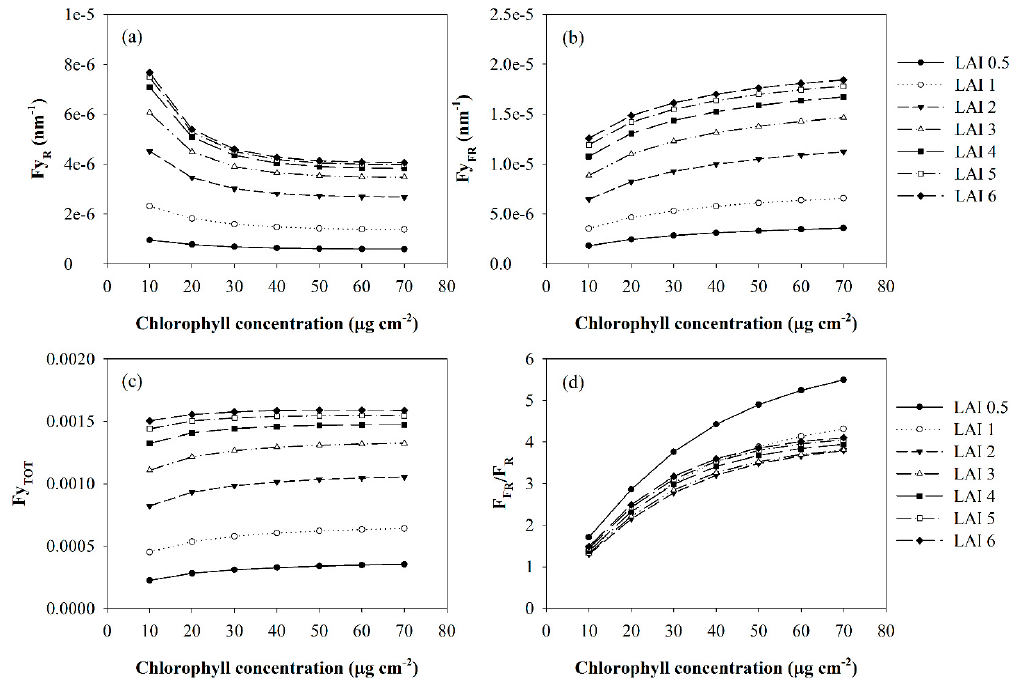
Figure 7. Simulated data. Relationships between the leaf chlorophyll concentration (µg·cm − 2 ) and: ( a ) Fy R (nm − 1 ); ( b ) Fy FR (nm − 1 ); ( c ) Fy TOT; and ( d ) the F FR /F R ratio. Fy is derived from SCOPE simulations for different LAI values. Values for incoming shortwave radiation were set to 1000 W·m − 2 .